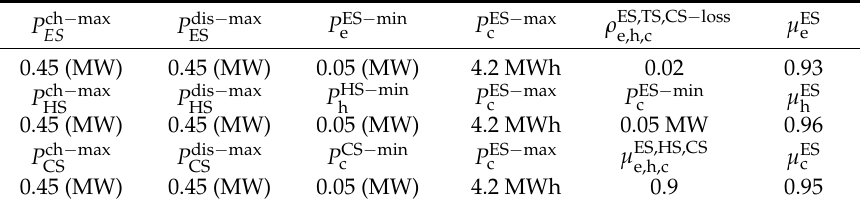
Figure 8. Output power characteristics of PV, PW, and SHE in a sample day.